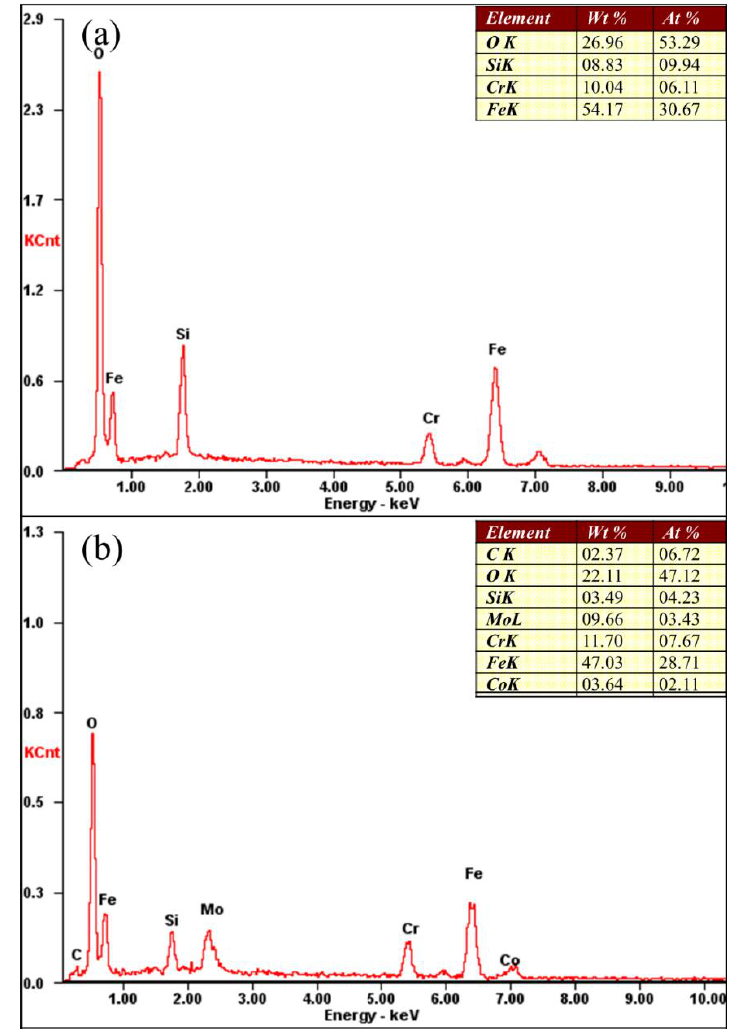
ff erent zones in Figure 10: ( a ) Zone 1; ( b ) Zone Figure 11. EDS results of different zones in Figure 10: ( a ) Zone 1; ( b ) Zone 2. Figure 11. EDS results of di